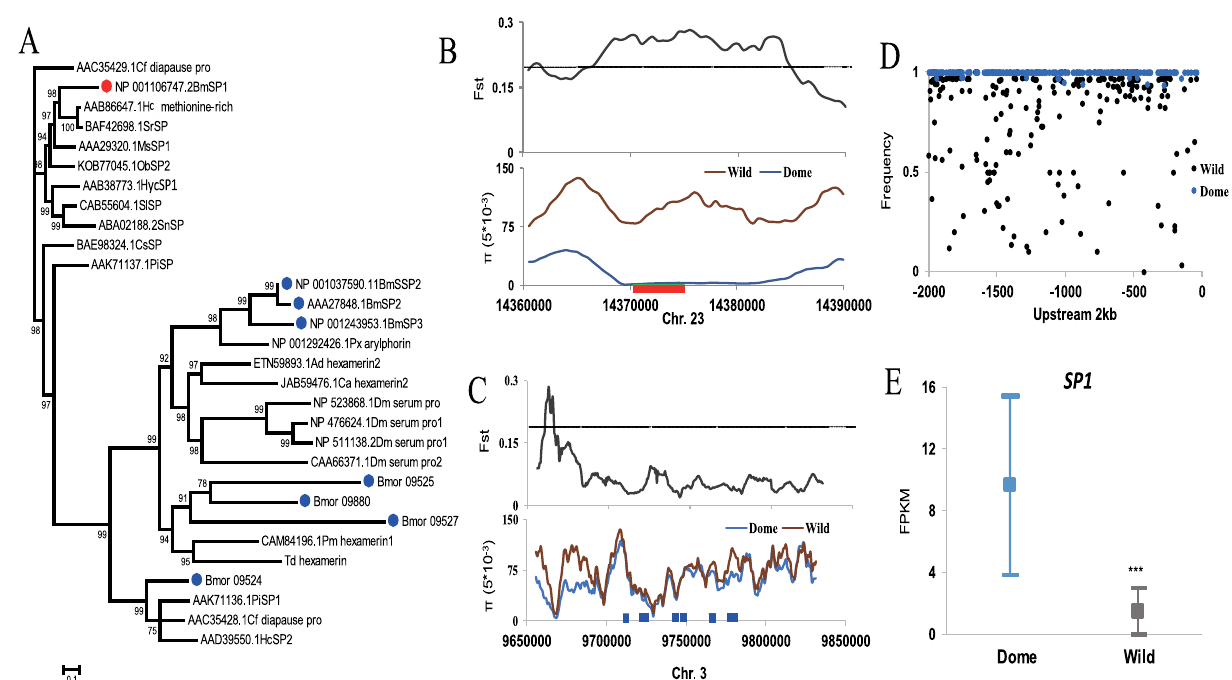
Fig 1. Molecular evolution of silkworm SPs. (A) Phylogenetic tree of insect Storage proteins based on Bayesian inference analyses. Full-length amino acid sequences were aligned to generate a phylogenetic tree. Bayesian posterior probability was shown for each node. Cf, Choristoneura fumiferana ; Bm, Bombyx mori ; Hc, Hyalophora cecropia ; Sr, Samia ricini ; Ms, Manduca sexta ; Ob, Operophtera brumata ; Hyc, Hyphantria cunea ; Sl, Spodoptera litura ; Sn, Sesamia nonagrioides ; Cs, Chilo suppressalis ; Pi, Plodia interpunctella ; Px, P lutella xylostella ; Ad, Anopheles darlingi ; Ca, Corethrella appendiculata ; Dm, Drosophila melanogaster ; Pm, Perla marginata ; Td, Thermobia domestica . Accession number for each protein is indicated ahead of abbrevation of each species. (B-C). Selection signatures of the silkworm SP s. Signature index—Population divergence coefficient ( Fst ) between the Chinese local trimoulting (CHN_L_M3) domestic silkworm group and the wild silkworms and nucleic acid diversity ( π ) in the silkworm populaton is shown along the genomic regions covering the SP genes. Dashed lines represent the top 5% Fst cutoff. The red square represents SP1 region which is located in Chromosome 23 and the blue squares represents the other SPs which are clustered in Chromosome 3. (D) Plotting of frequency of reference genotype for each SNP position in the upstream 2 kb region of SP1 , indicating many mutant alleles with fairly high allelic frequency in the wild silkworm population. (E) Expression level indicated as FPKM of SP1 in the ova of domestic and wild silkworms. The three data pot indicate the highest value with 95% confidence, the average and the lowest value with 95% confidence, respectively. ��� , FDR corrected p < 0.001. Dome, the domestic silkworm. Wild, the wild